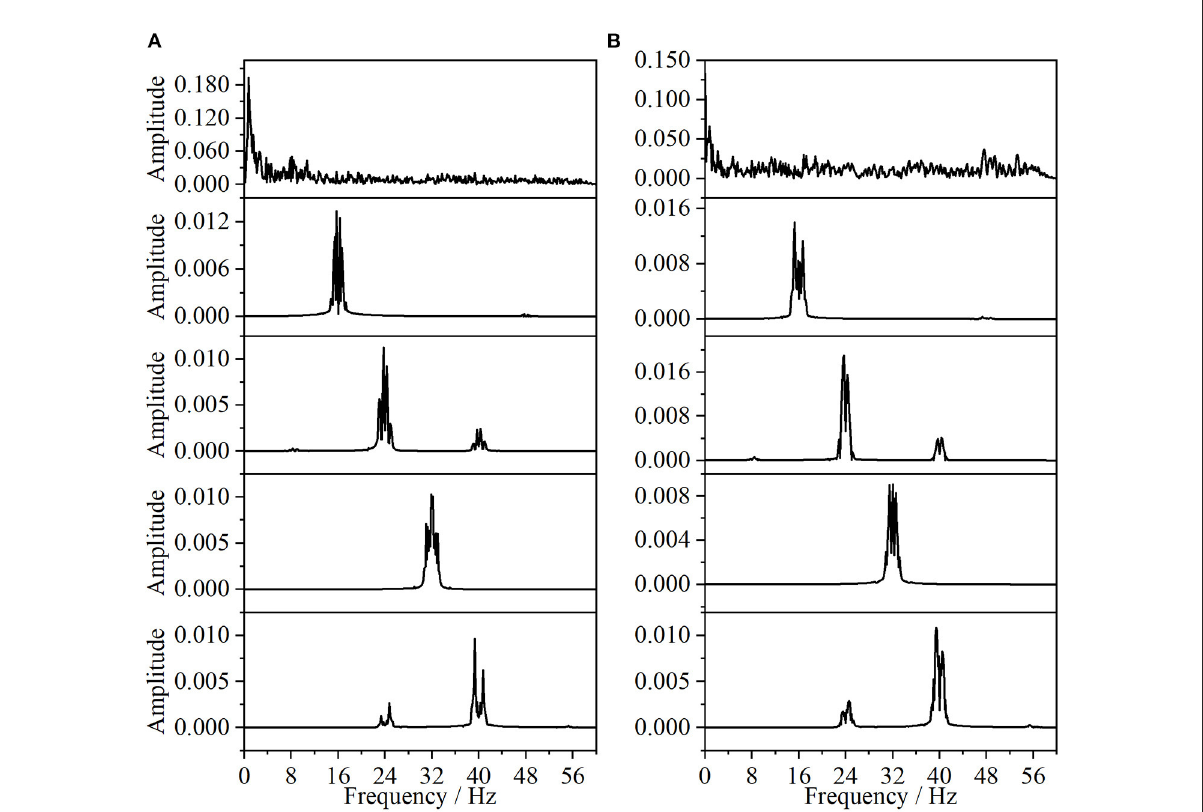
FIGURE4 Spectrum of wavelet packet decomposition signal (from top to bottom, the normalized signal after pre-processing, extracted after wavelet packet transform for 16, 24, 32, and 40 Hz bands, respectively). (A) EEG, (B)